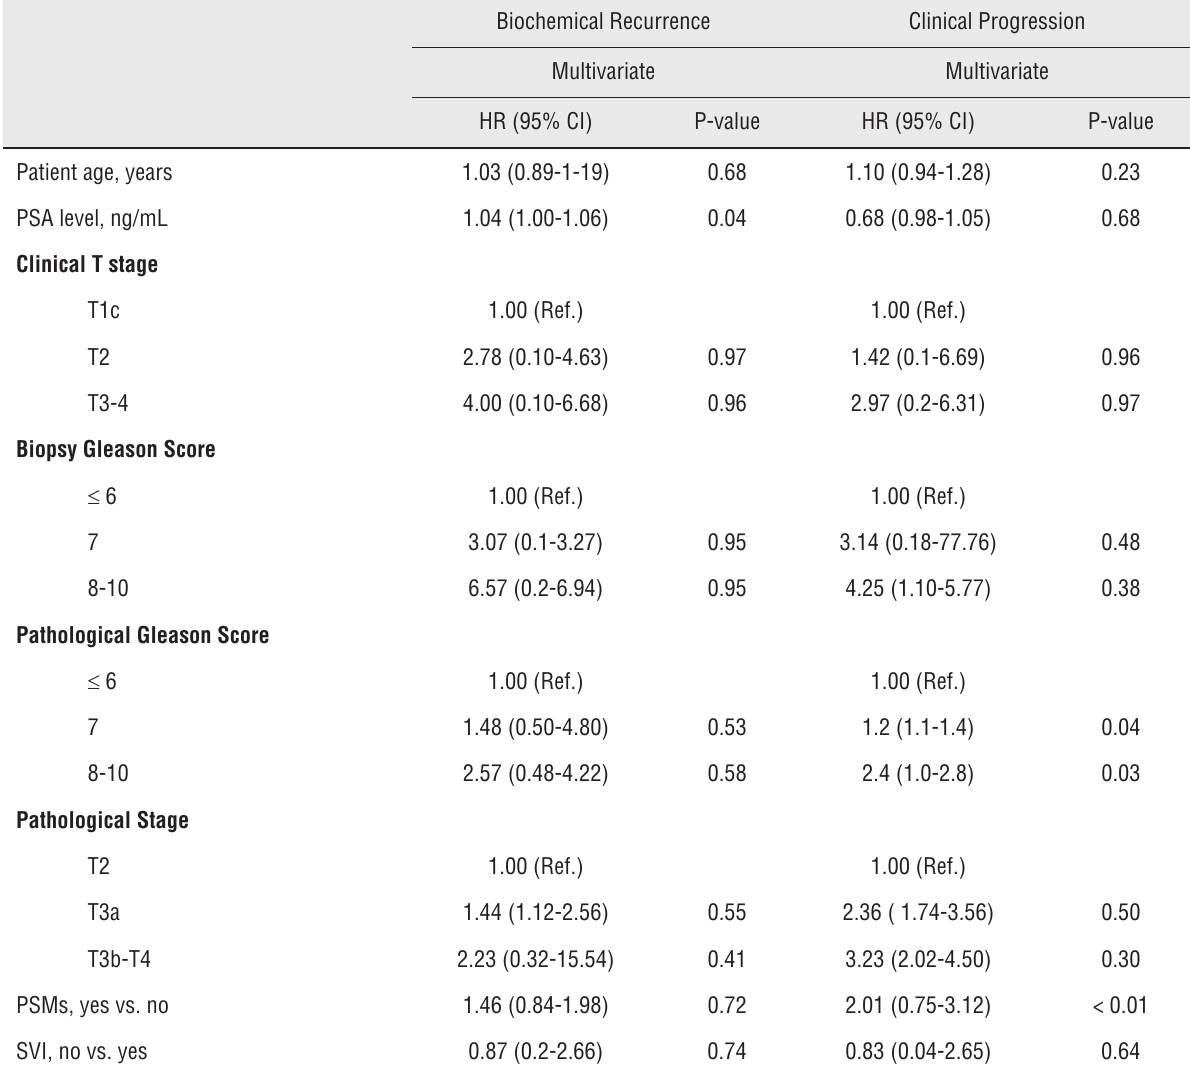
Table 2 - Multivariate cox regression analysis of preoperative and pathological predictors of biochemical recurrence and clinical